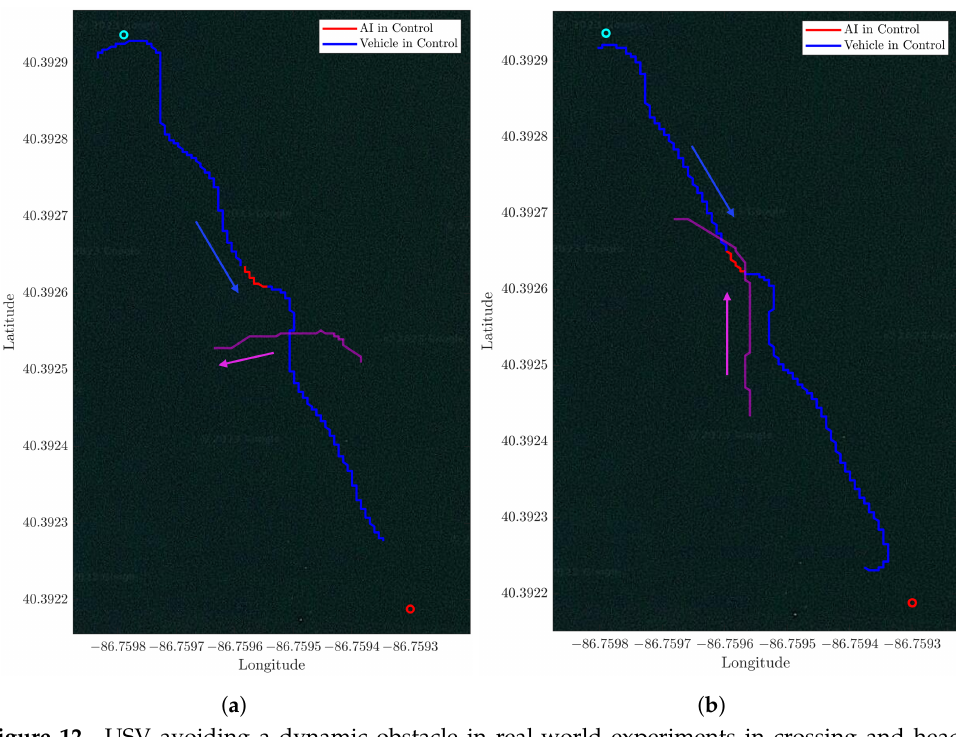
Figure 12. USV avoiding a dynamic obstacle in real-world experiments in crossing and head- on scenario. ( a ) Crossing scenario. ( b ) Head-on